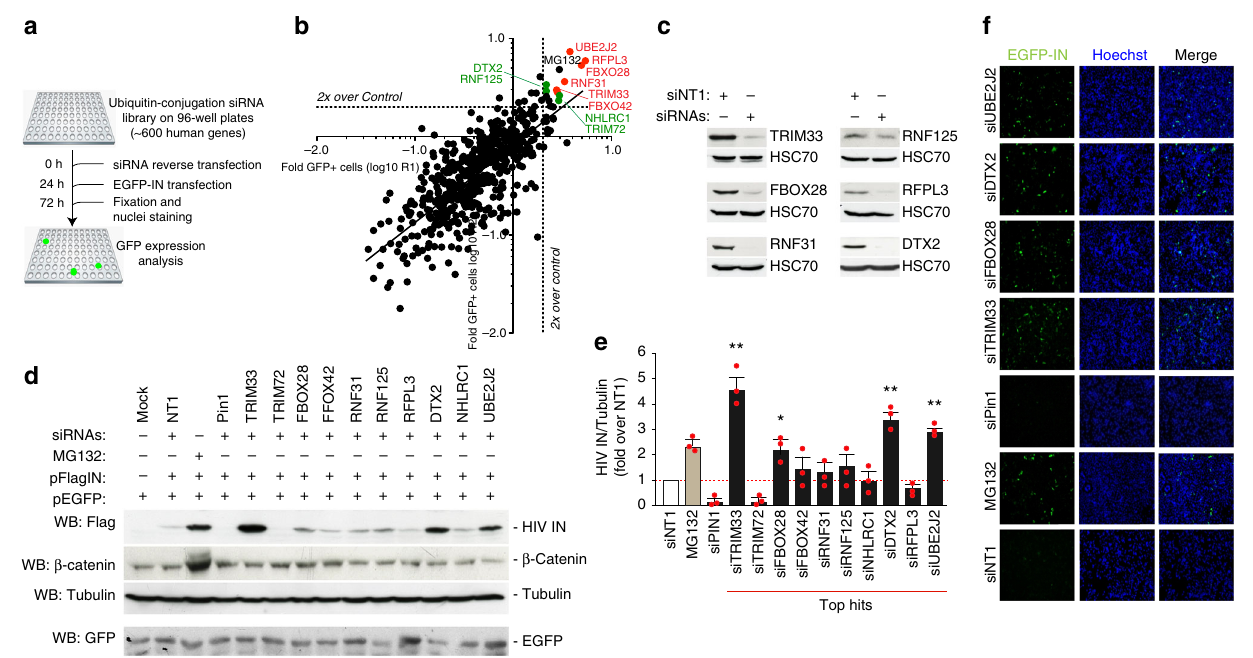
Fig. 2 High-throughput, siRNA-based screening to identify cellular factors regulating HIV-1 integrase stability. a Work fl ow for the siRNA-based screening. Cellular fl uorescence, as surrogate of IN levels, was analyzed by automated, high-content fl uorescent microscopy. b Results of screening. The graphs show the log10 values of the fold change of EGFP-positive cells over control in the two replicate screenings (R1 and R2). The dotted lines show 2x increase over Control (pool of results using 4 non-targeting siRNAs and mock-transfected cells). The 6 siRNAs in red are those that were in the top 10 in both screenings. The 4 siRNAs in green are those that were among the top 10 in one of screening while anyhow showing an effect ≥ 2 fold over control in the other screening. The effect of MG132 is shown in blue. c Con fi rmation of effective silencing of Pin1, TRIM33, FBOX28, RNF31, RNF125, RFPl3, and DTX by immunoblotting with the respective antibodies. Cells transfection of non-targeting siRNA1 (siNT1) was used as a control. HSC70 served as a loading control. d Representative immunoblot showing the levels of HIV-IN after knock-down of the top 10 E3 ligases from the screening. HeLa cells were transfected with siRNAs against the identi fi ed factors or with a siRNA against Pin1, followed by transfection of Flag-IN and EGFP. Forty-eight hour later the levels of IN were assessed by anti-Flag immunoblotting. Tubulin served as a loading control; β -catenin was used to con fi rm effect of the MG132 treatment. The bottom panel shows a western blotting for EGFP in a representative experiment to show lack of effect of any of the tested siRNAs on EGFP levels. e Quanti fi cation of the levels of HIV-1 IN after knock-down of the top 10 E3 ligases identi fi ed by the screening. Experiments were performed as in panel d . IN levels are expressed after normalization for tubulin and as fold over siNT1. Data are mean ± SEM; n = 3 independent experiments; * P < 0.05; ** P < 0.01; one-way ANOVA. f Representative high-content microscopy images showing of EGFP-IN-expressing cells after depletion of four cellular ubiquitin- conjugation factors (TRIM33, FBXO28, siDTX2, and siUBE2J2) or (LUBAC), an E3 ligase that generates linear poly-ubiquitin chains 30 ; DTX2, a member of deltex protein family, acting as a